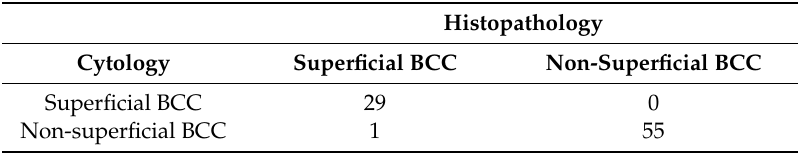
Table 3. Evaluation of cytology in subtype BCC